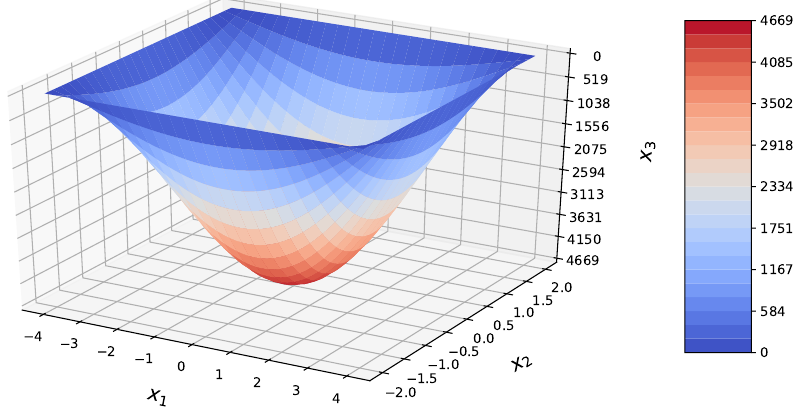
Figure 14. Three-dimensional plot of the bending moment M 11 of simply supported rectangular